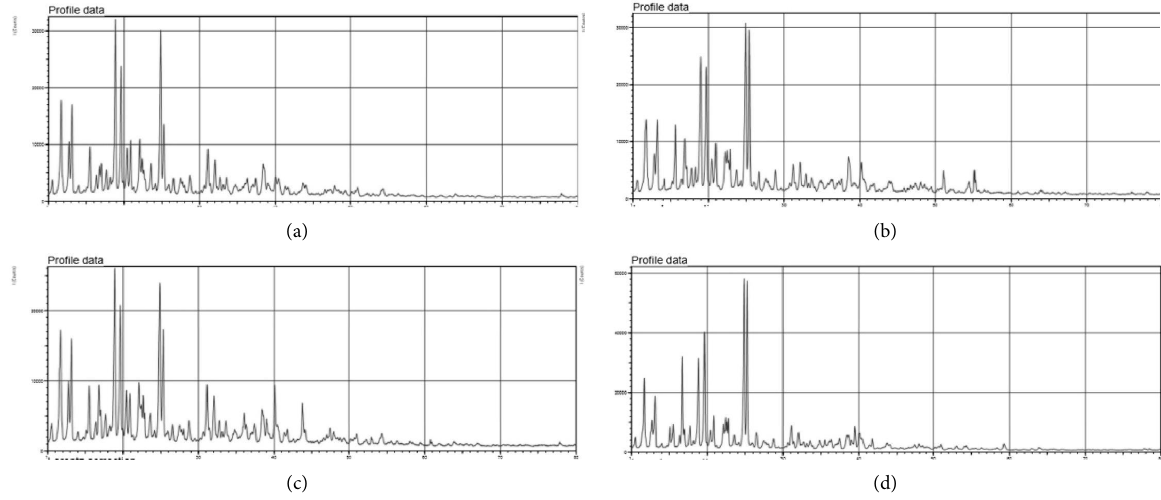
Figure 2: Te XRD pattern of cocrystallized moringa leaves extract powders (a). Vacuum-dried moringa leaves extract powders (b). Plated moringa leaves extract powders and sucrose (d).